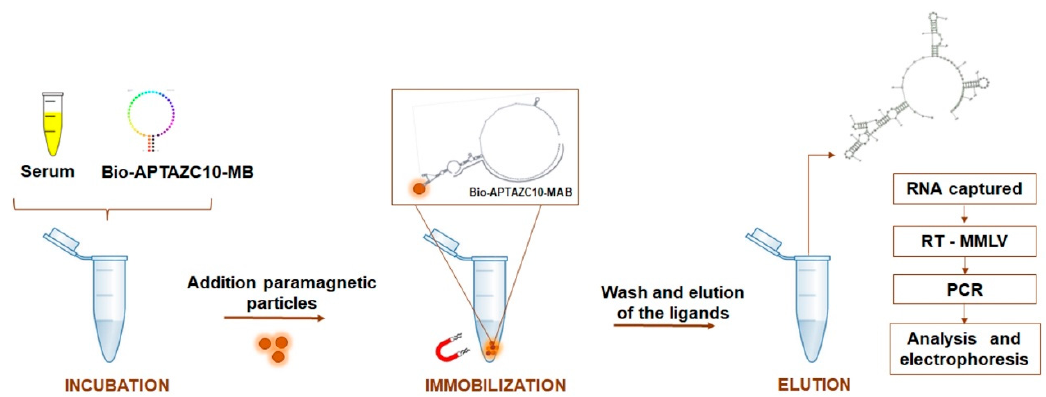
Figure 6. APTA-RT-PCR strategy for DENV and ZIKV detection. Biotinylated aptamer APTZC10-MB incubated directly with human serum, coupled with paramagnetic particles allowed the capture of viral RNA. After washes, the genetic material from the flaviviruses was submitted to RT-PCR, and the amplified products were analyzed by agarose electrophoresis .